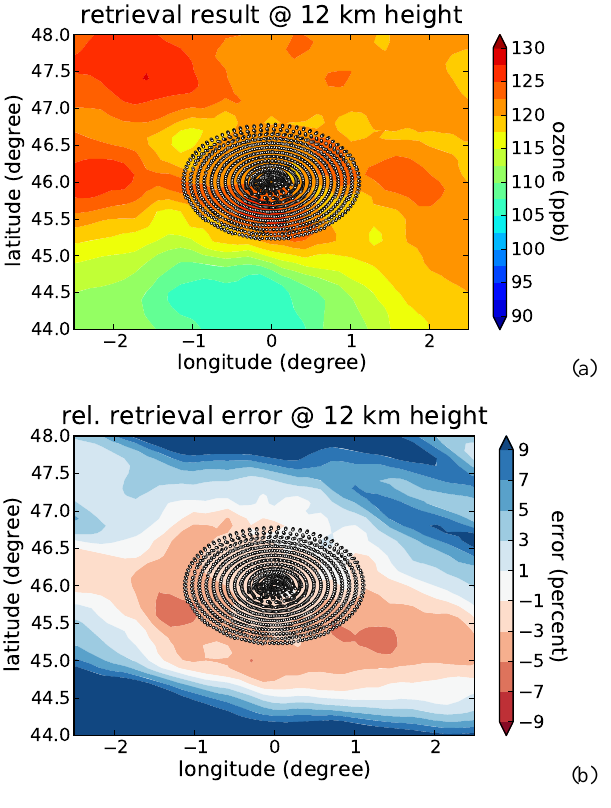
Fig. 10. Depicted is the retrieval result (a) and relative error (b) of a tomographic reconstruction with panning being reduced to a span of 50 ◦ instead of 90 ◦ .